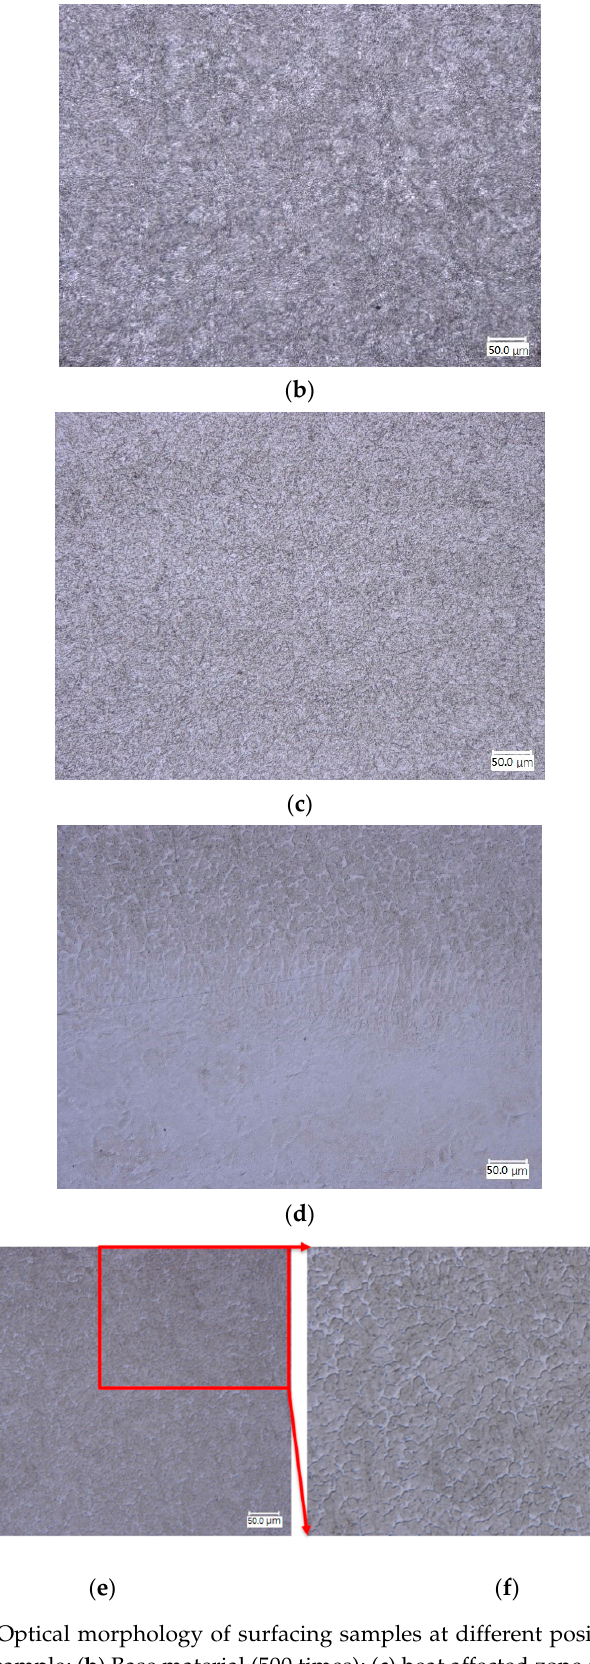
Figure 5. Optical morphology of surfacing samples at different positions. ( a ) Physical image of corrosion sample; ( b ) Base material (500 times); ( c ) heat affected zone (500 times); ( d ) bonding area (500 times); ( e ) surfacing area (500 times) ( f ) surfacing area (1000